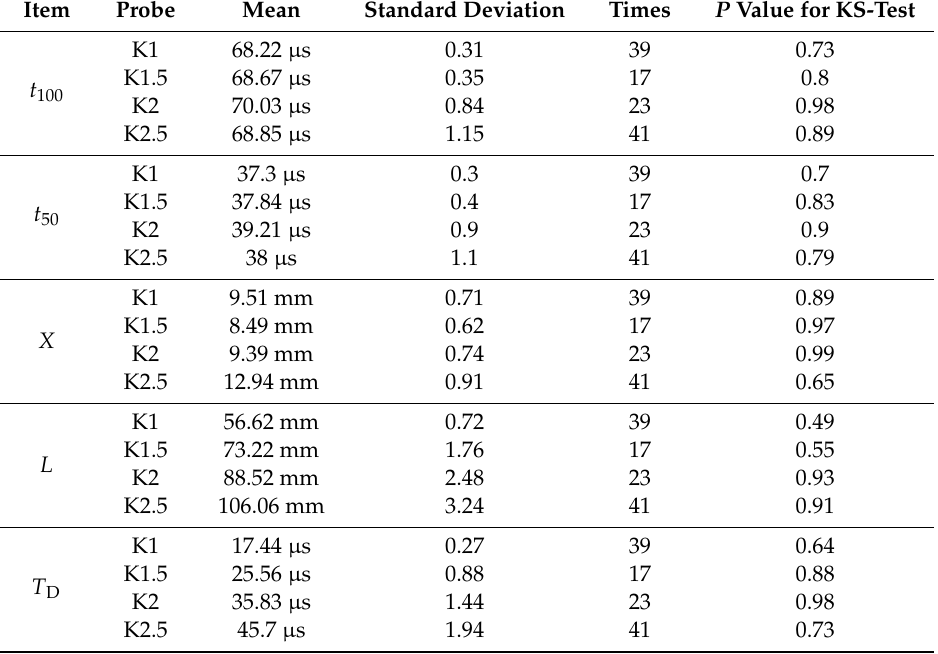
Table 1. Results of Experiment 1 (EXP1) and Experiment 2 (EXP2).